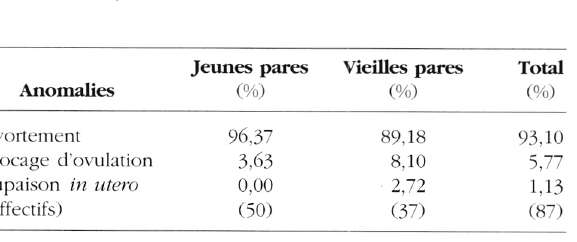
Tableau I. - Pourcentage des différentes anomalies rencontrées chez les deux catégories de femelles pares de Glossina palpalis pal­ palis en zone forestière de Côte